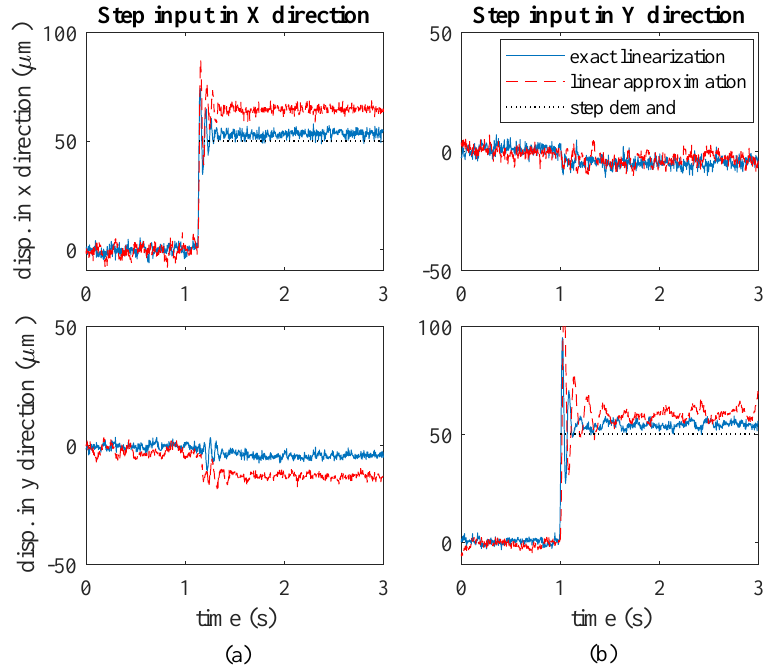
Figure 12. Displacement response of the non-rotating thin-walled rotor due to ( a ) step change in X demand ( b ) step change in Y